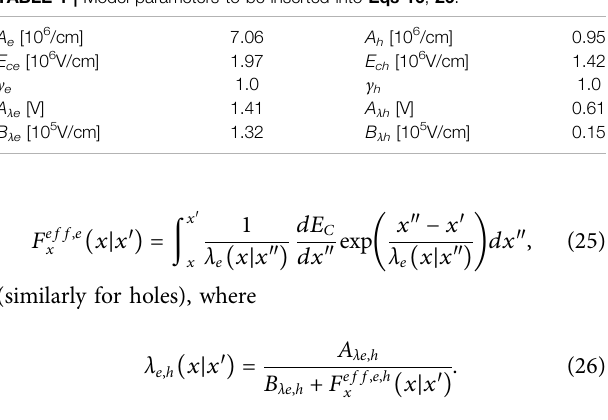
TABLE 1 | Model parameters to be inserted into Eqs 16 , 26 . A e [10 6